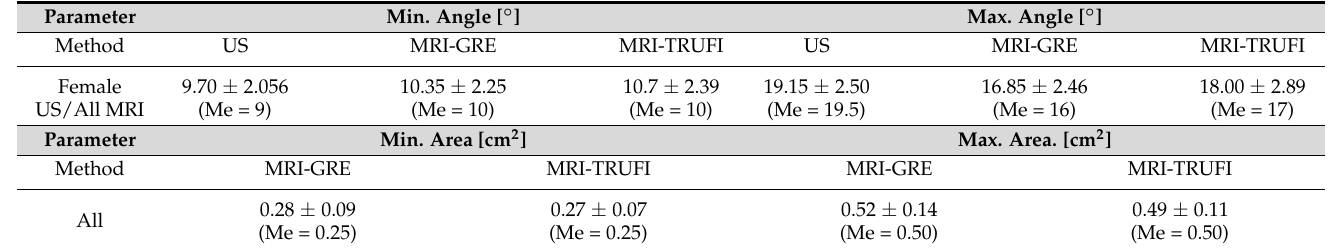
Table 2. The minimum and maximum angles and the areas of the vocal folds in the group of patients with normal postoperative VF mobility obtained during quiet breathing via US and